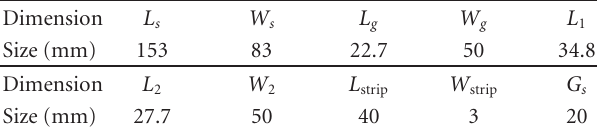
Figure 1: The geometry of the proposed antenna. Table 1: Antenna dimensions.